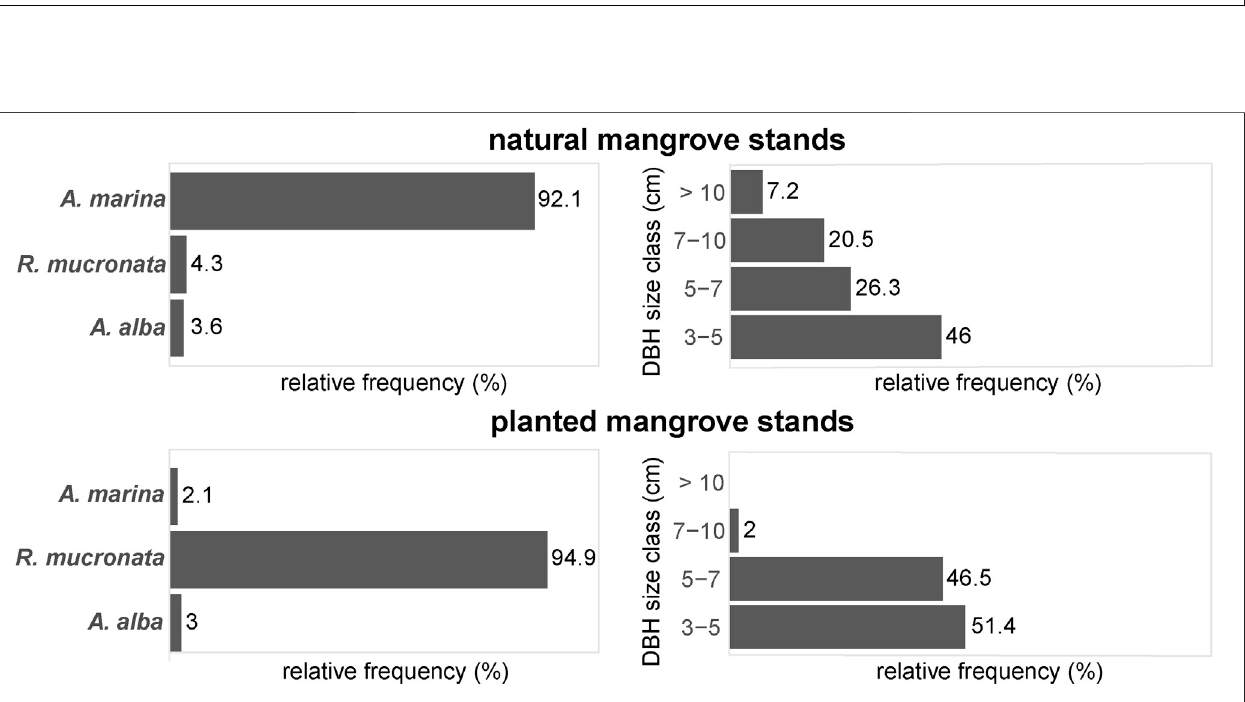
FIGURE4| Foreststructureofnaturalandplantedmangrovestandsin fi eldvalidationplotsoftheGISstudyintermsofrelativetreedensityperspecies(left)andthe relative distribution of trees per DBH size class (right).